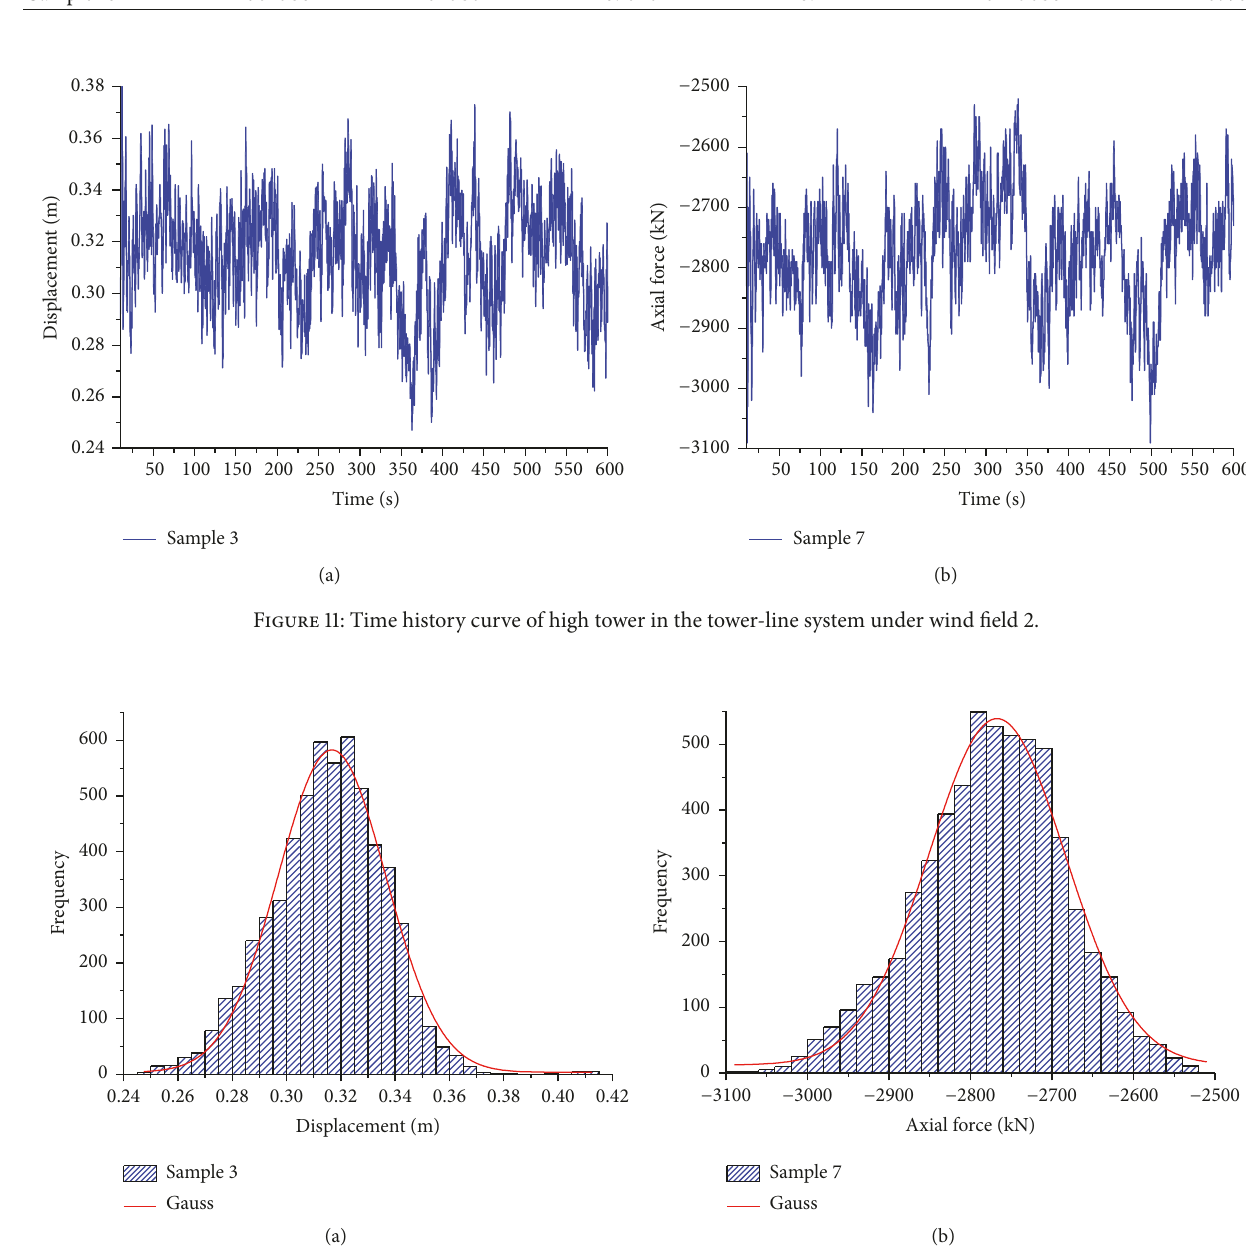
Figure 12: Frequency histogram of high tower in the tower-line system under wind field